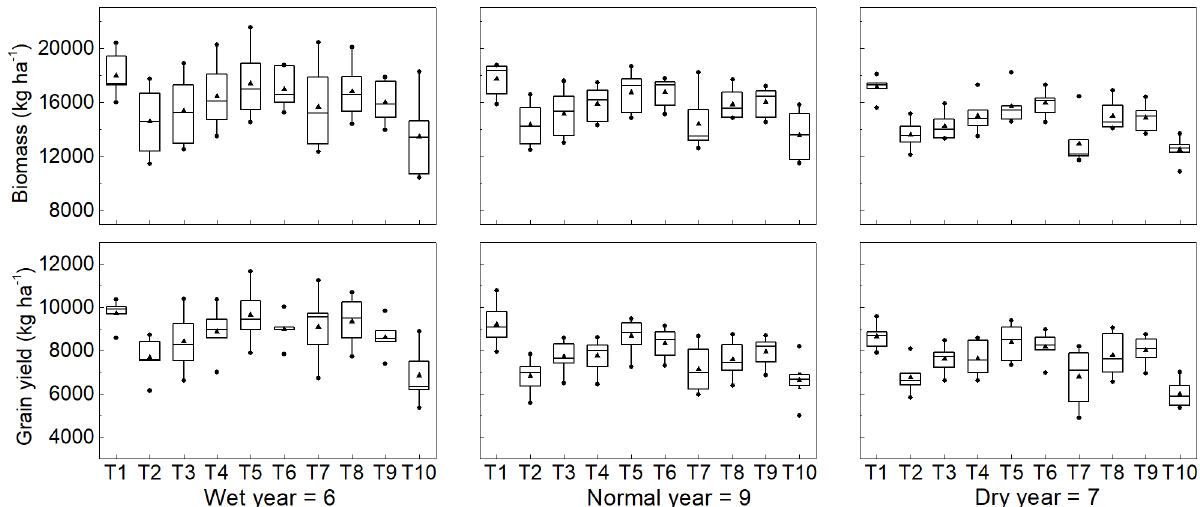
Fig 4. Simulated grain and biomass yield for different irrigation treatments. The triangle indicates the median. The circle indicates the 75 and 25 percent. The middle line indicates 50 percent.